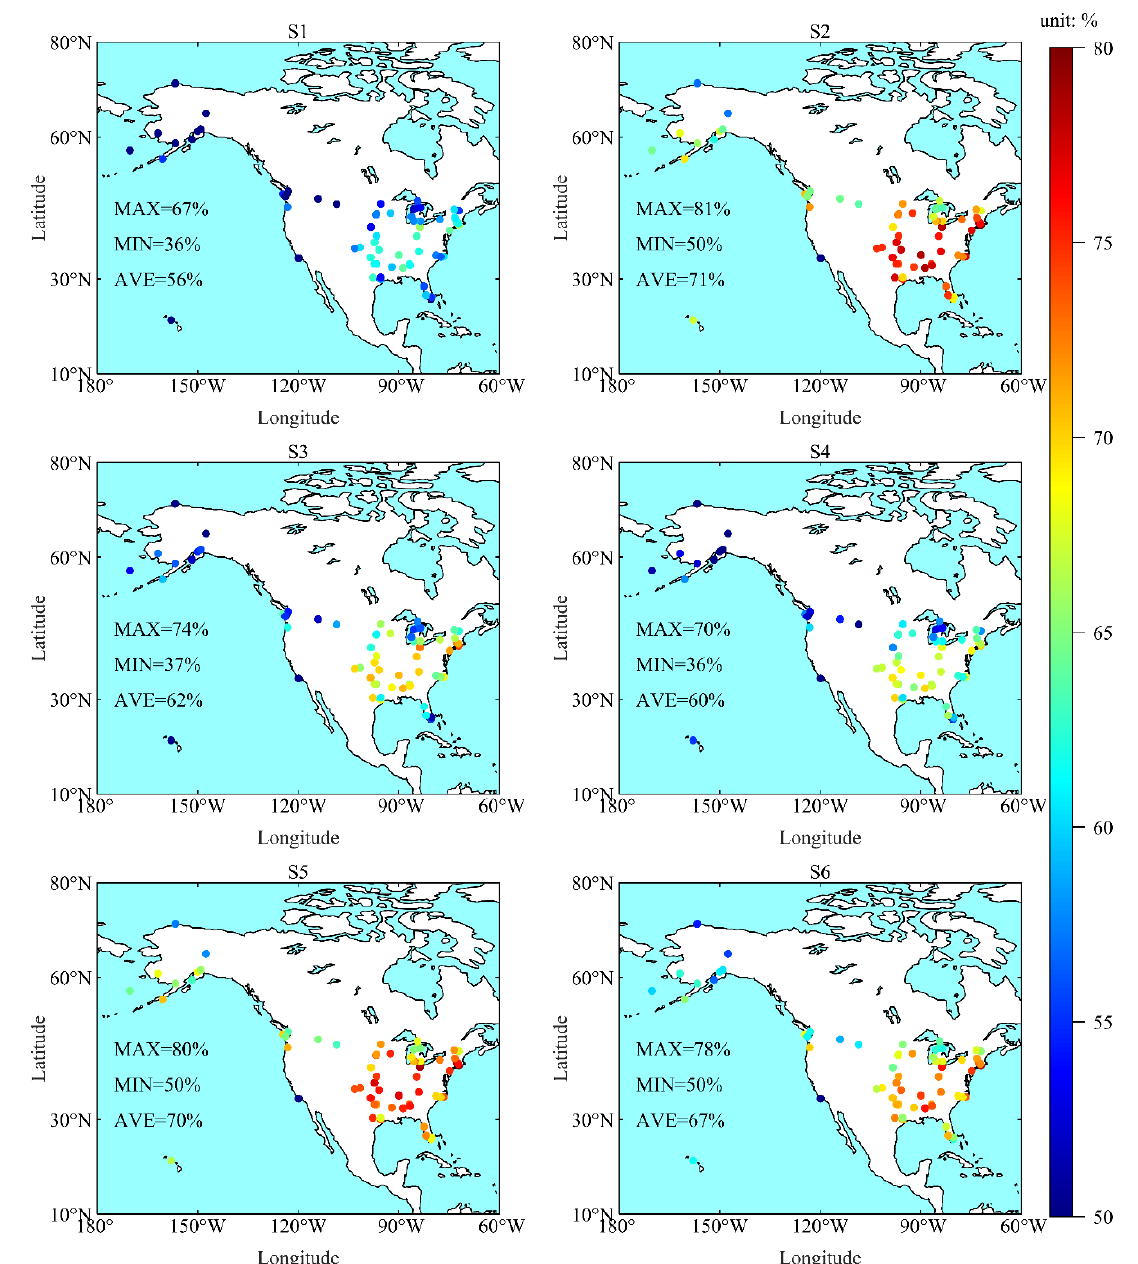
Figure 7. TSS values at the 66 stations resulting from the six strategies S1, S2, S3, S4, S5, and S6 defined in Table 6.